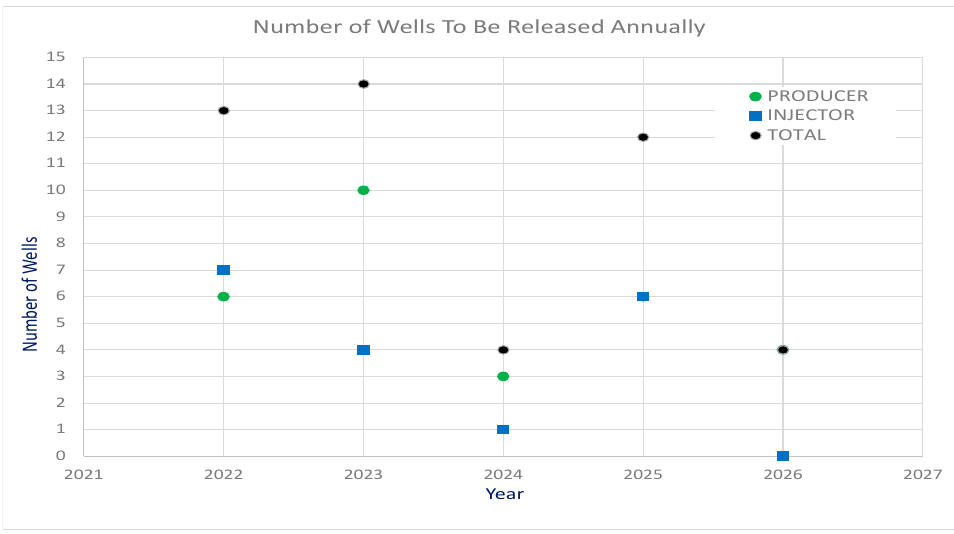
Figure 3. Number of wells to be released annually.